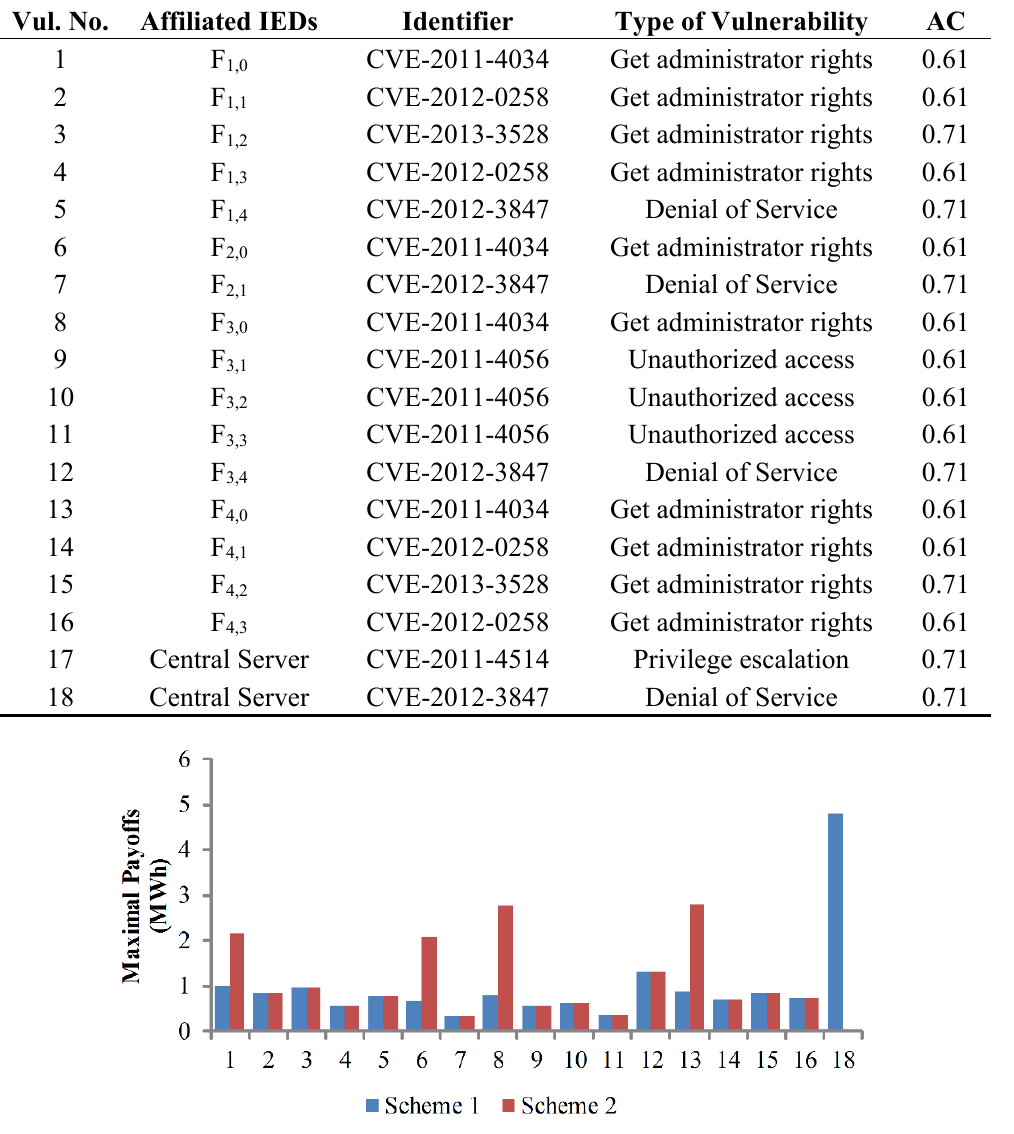
Table 3. Information of vulnerabilities.